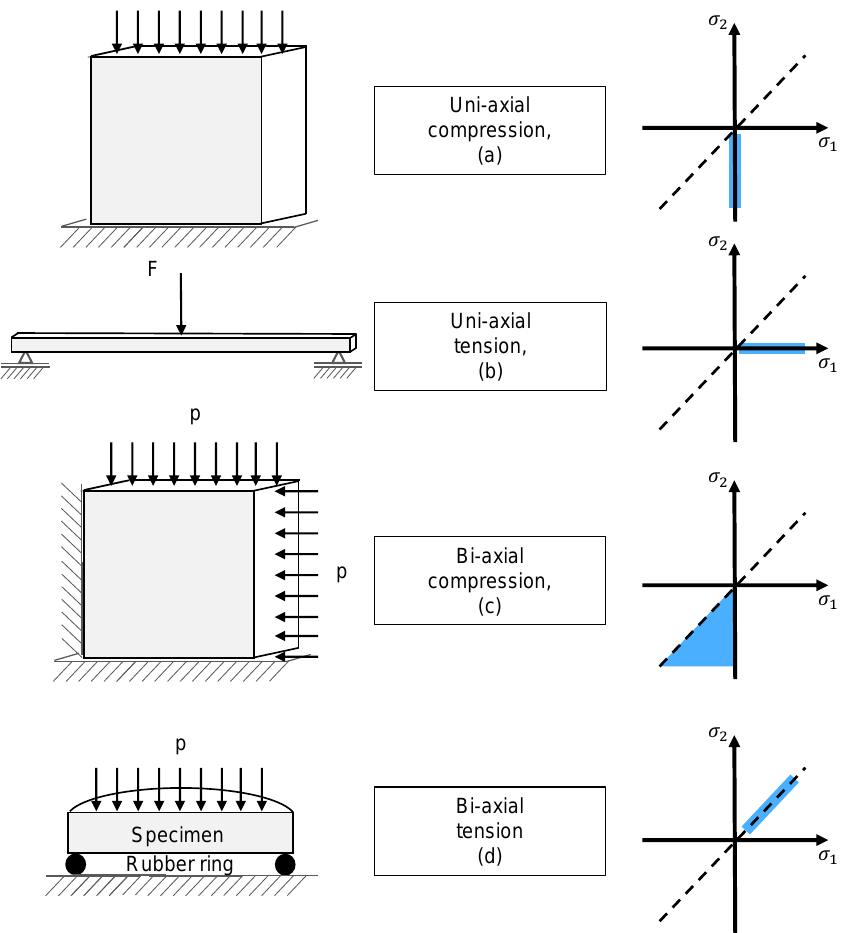
Figure 5. Uni- and bi-axial testing methods for compression ( a ), tensile ( b ), bi-axial compression ( c ), and bi-axial tensile ( d ), together with their respective position in principal stress